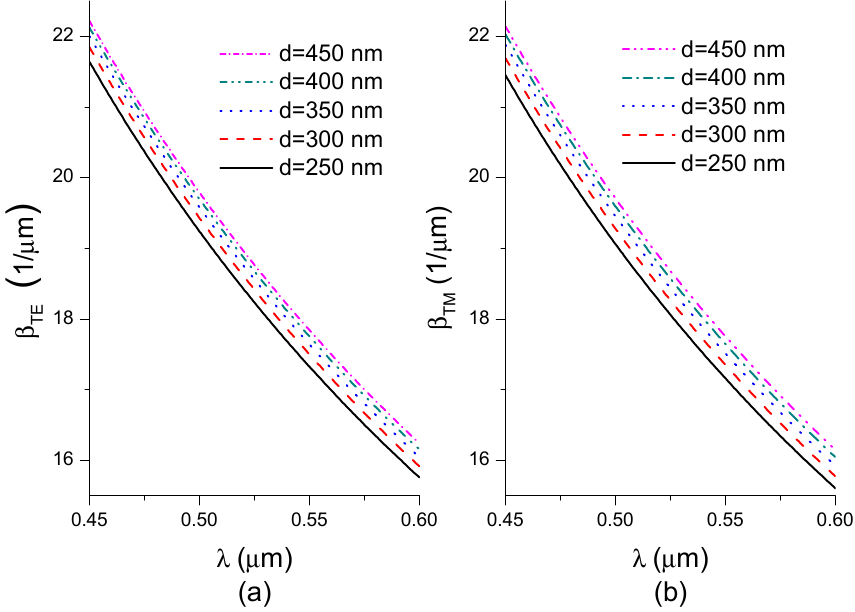
Figure 5. Dependence of the propagation constants on wavelength ( a ) TE polarization and ( b ) TM polarization (SU-8 thickness of 250 nm, 300 nm, 350 nm, 400 nm, and 450 nm).